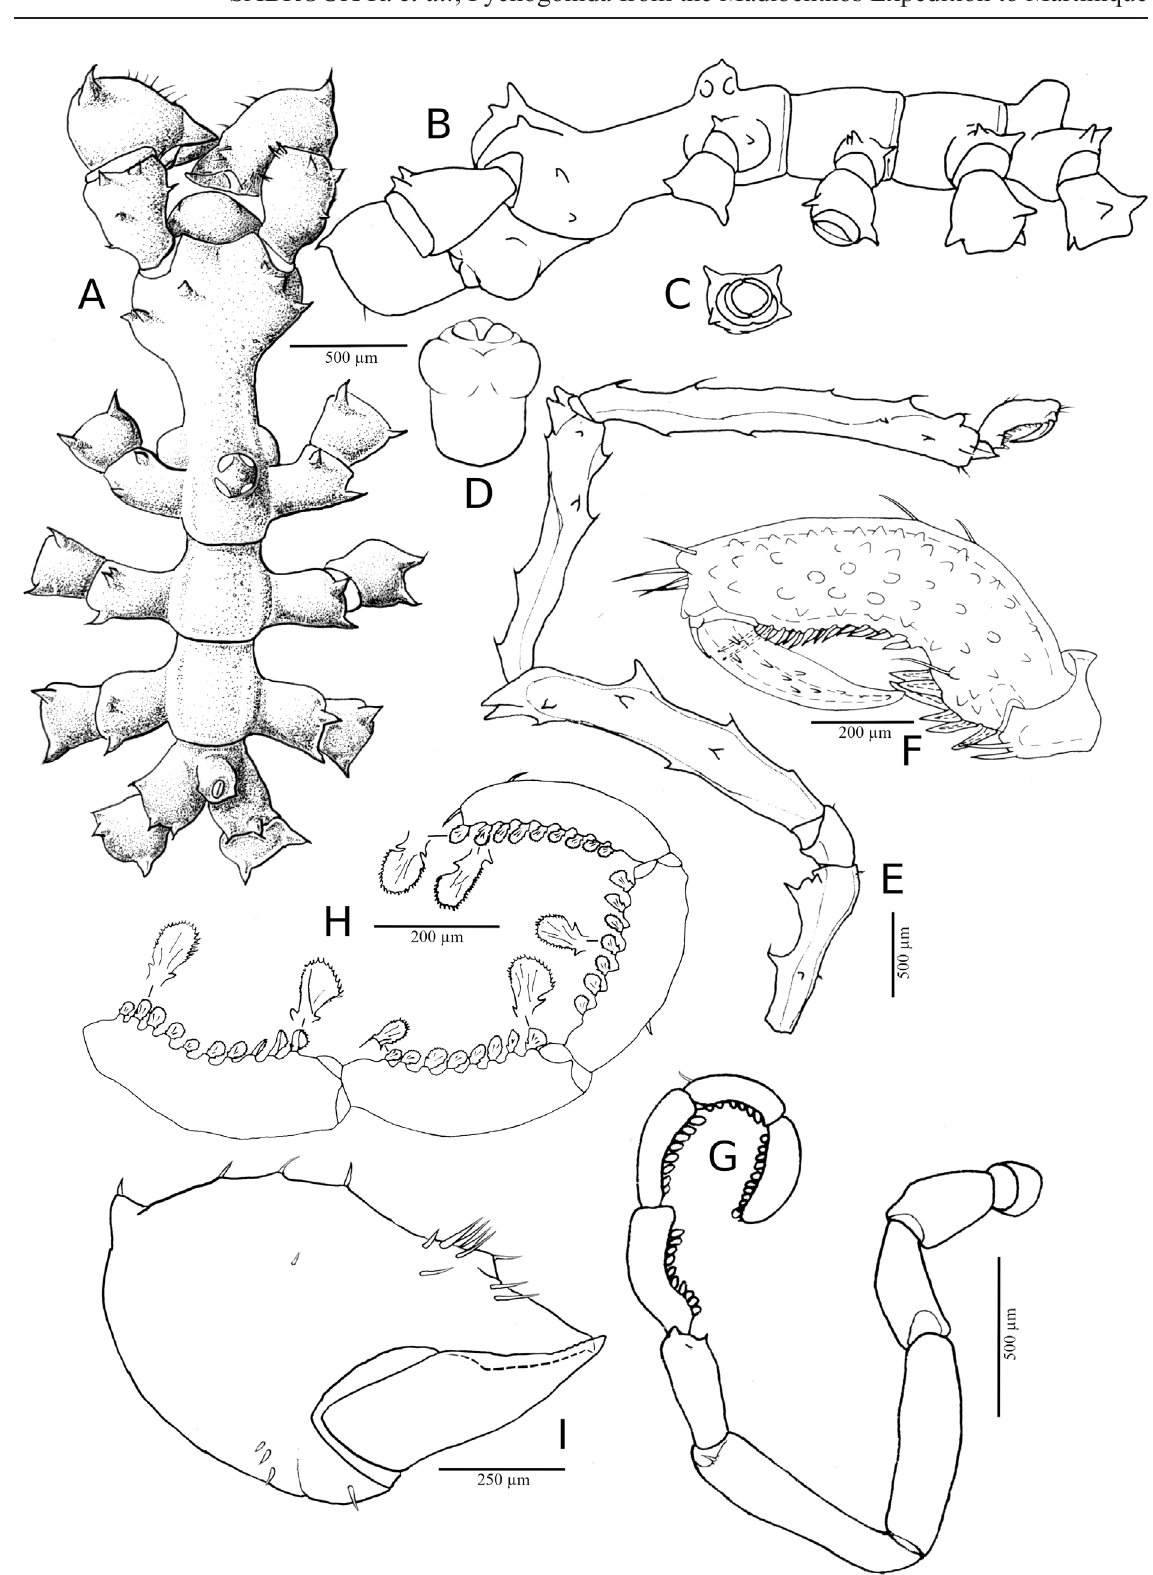
Fig. 10. Pallenoides cf. amazonicus Stock, 1974, ♀, MNHN-IU-2016-866. A . Body, dorsal view. B . Oviger. C . First coxa of third leg, frontal view. D . Proboscis, ventral view. E . Second leg. F . Tarsus and propodus of second leg. G . Oviger. H . Oviger strigilis, with close-up of some compound teeth. I .